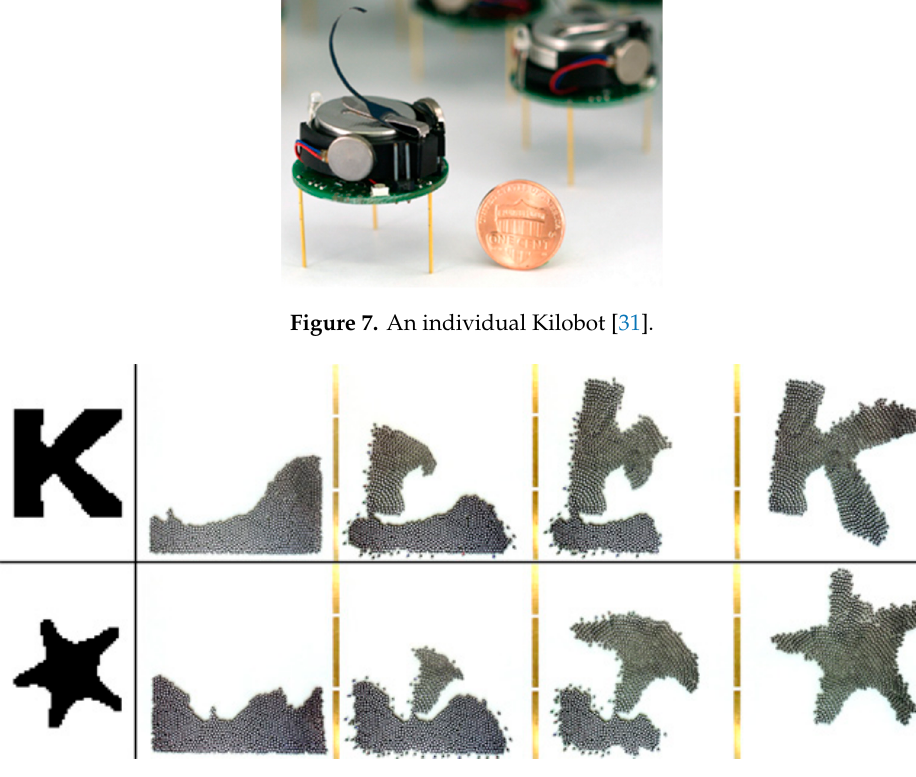
Figure 8. A swarm of 1024 Kilobots gradually arrange themselves into a ‘K’ shape and a star shape [31]